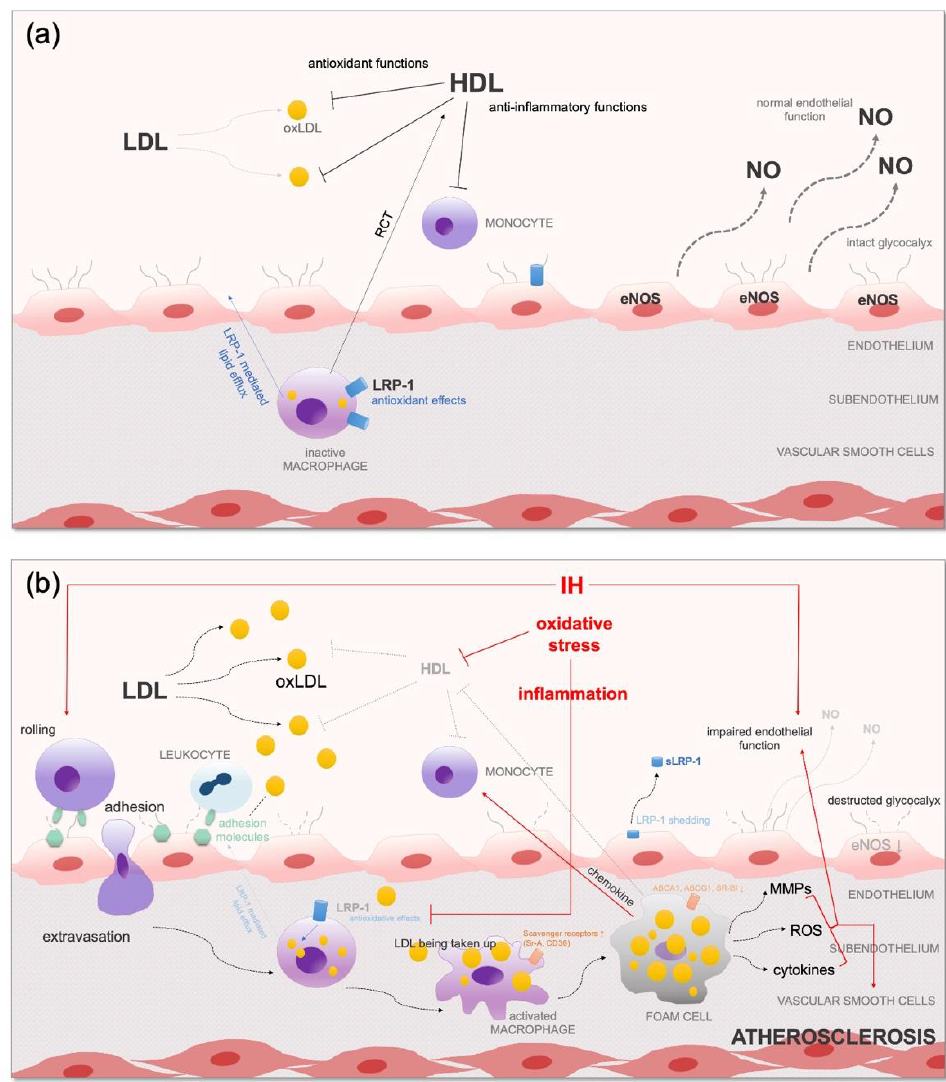
Figure 3. ( a ) Antioxidant effects of HDL and LRP-1 and normal endothelial function; ( b ) impaired antioxidant mechanisms with consequential oxidative stress, inflammation and endothelial dys- function in OSA. ABCA1 — ATP-binding cassette transporter A1; ABCG1 — ATP-binding cassette